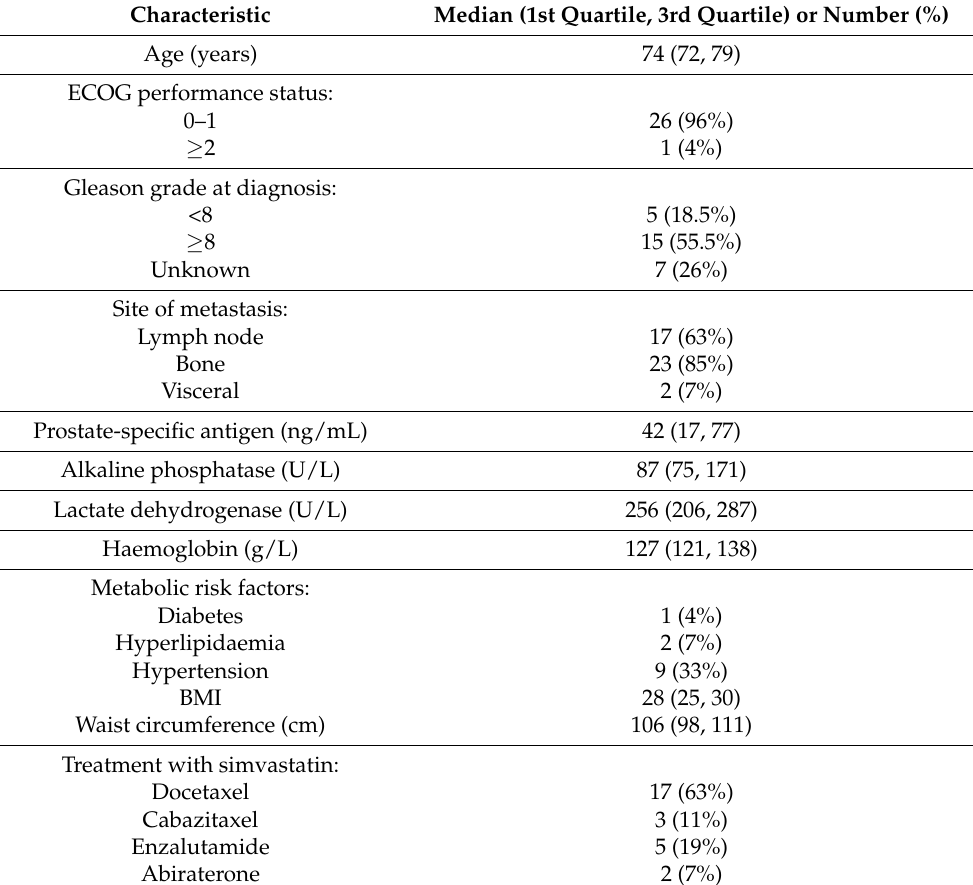
Table 1. Baseline clinical characteristics of the cohort and standard treatment received with